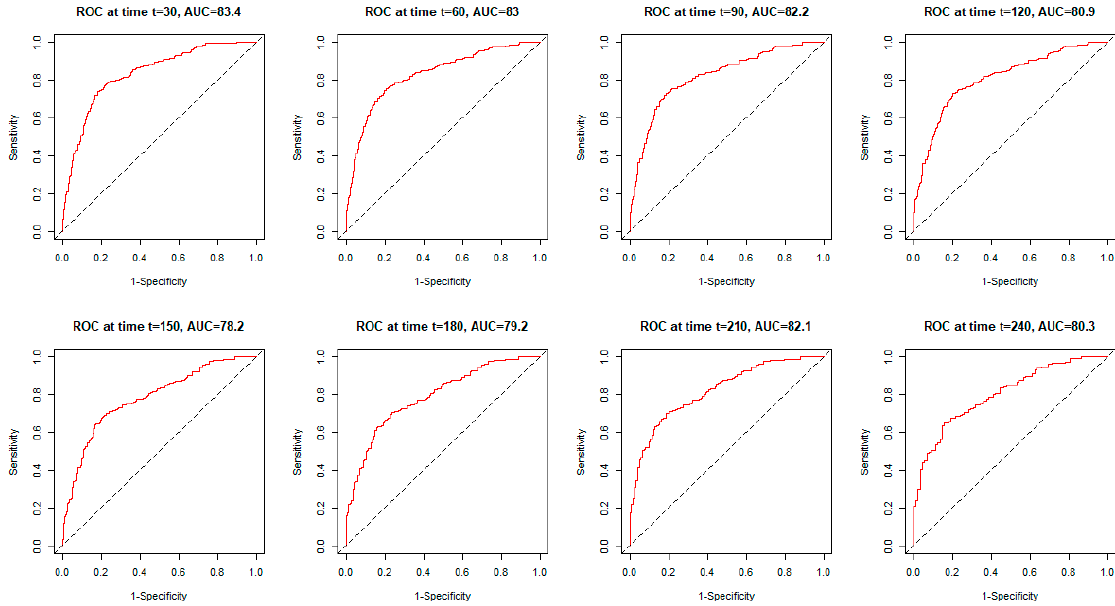
Figure 4. The ROC curves for the GRAM-COVID score for 30–240 days among COVID-19 patients. The survival curves for all COVID-GRAM score levels were determined based on the Kaplan–Meier function. The curves were compared using the log-rank test. The probability of survival is significantly different in the individual risk groups (Figure 5).